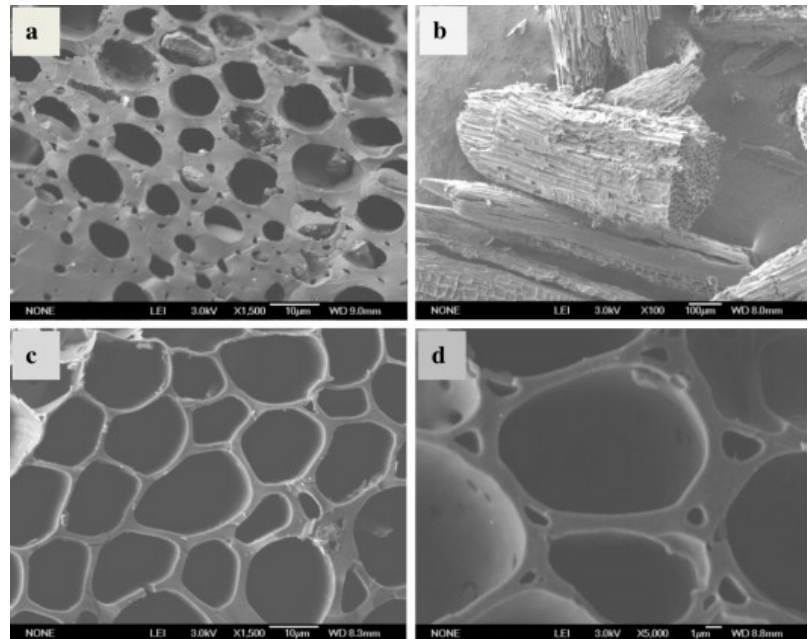
Figure 2. SEM images of carbonized bamboo ( a ), and bamboo-derived granular renewable carbon with magnification of ×100 ( b ), ×1500 ( c ) and ×5000 ( d ) [14].